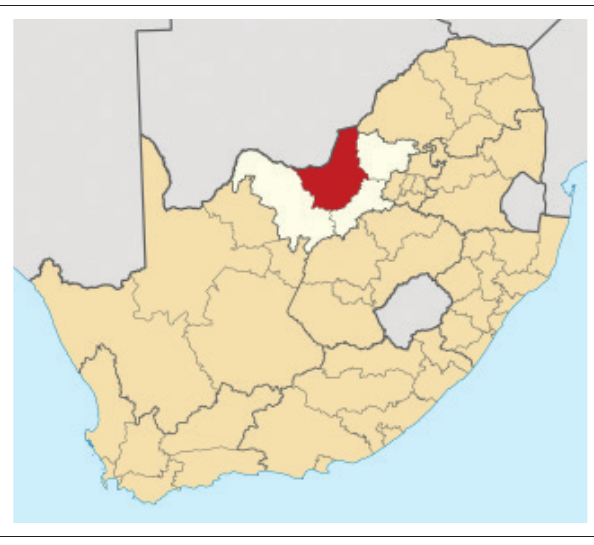
FIGURE 1: Map of South Africa, the red part, shows Mafikeng within the North West